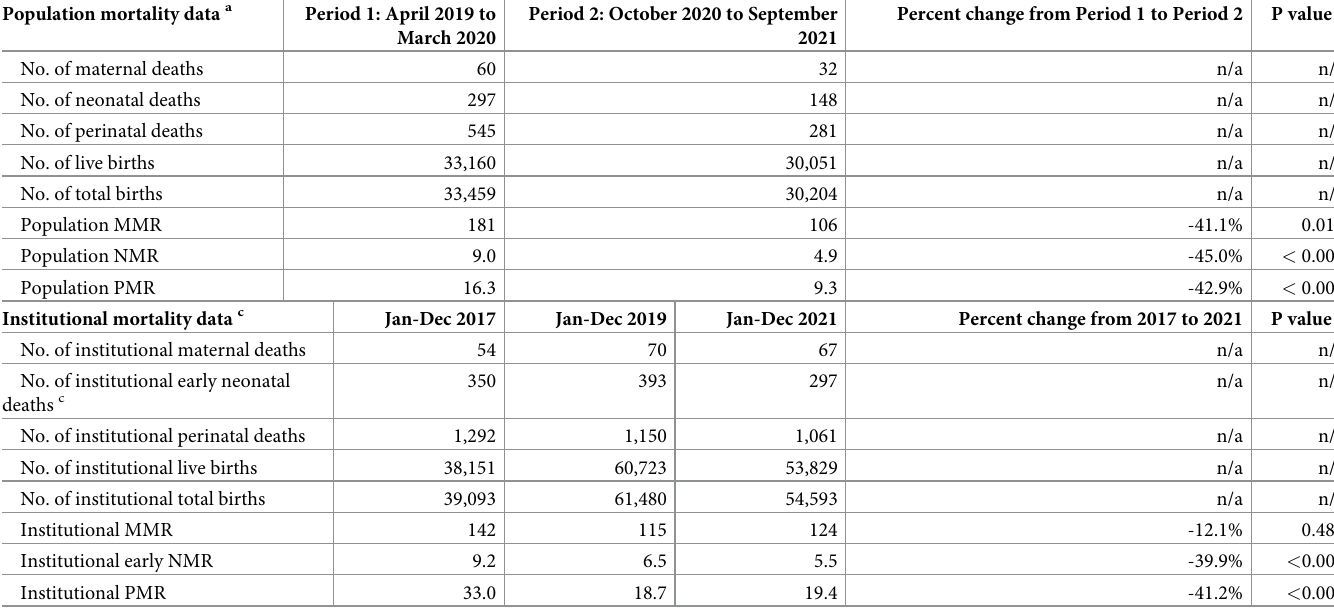
Table 4. Population and institutional mortality rates.